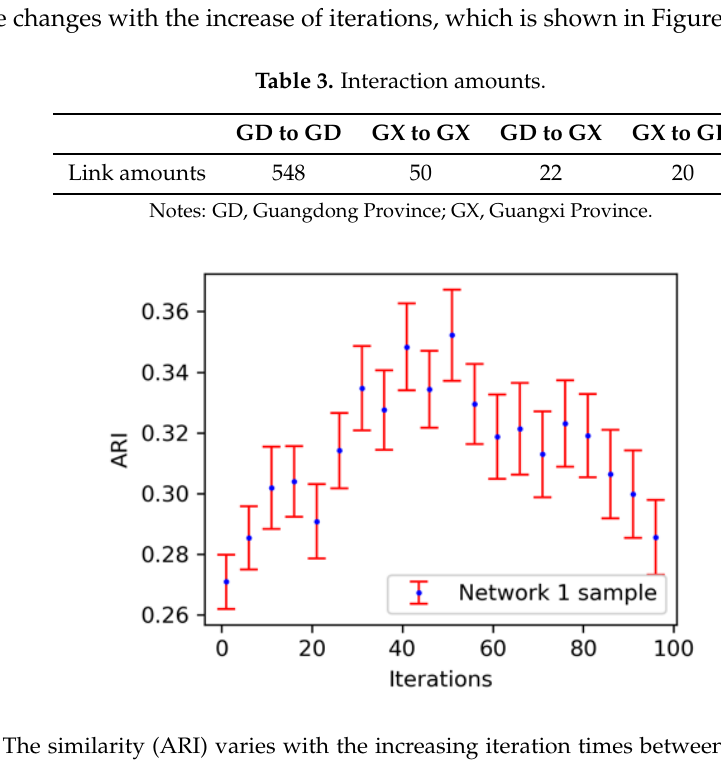
Figure 7. The similarity (ARI) varies with the increasing iteration times between the classification results of the MDND on and the administrative divisions. It can be seen that the ARI value does not increase obviously with the increase of iterations, and the volatility is very large.